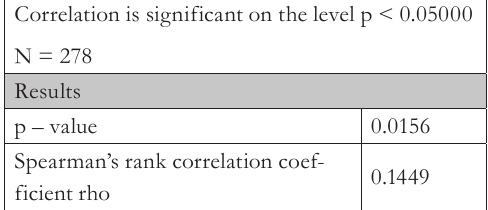
Tab. 2 - Testing results of the first hypothesis. Source: own processing Correlation is significant on the level p <